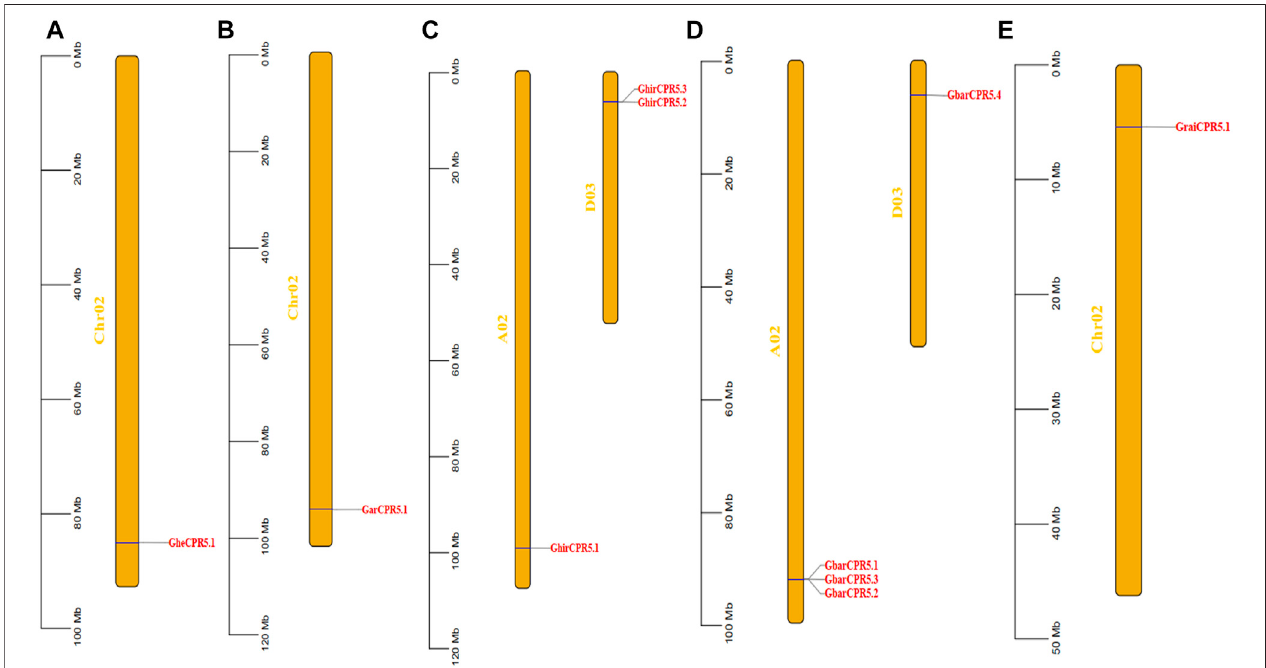
FIGURE 3 | Distribution of the CPR5 genes on chromosomes of different cotton species i.e., A1, A2, AD1, AD2, D5. (A) A1 ( Gossypium herbaceum ). (B) A2 ( Gossypium arboreum ). (C) AD1 ( Gossypium hirsutum ). (D) AD2 ( Gossypium barbadense ). (E) D5 ( Gossypium raimondii ). The scale bar represents the chromosome length. The yellow bar indicates the chromosomes. The gene on each chromosome is highlighted in